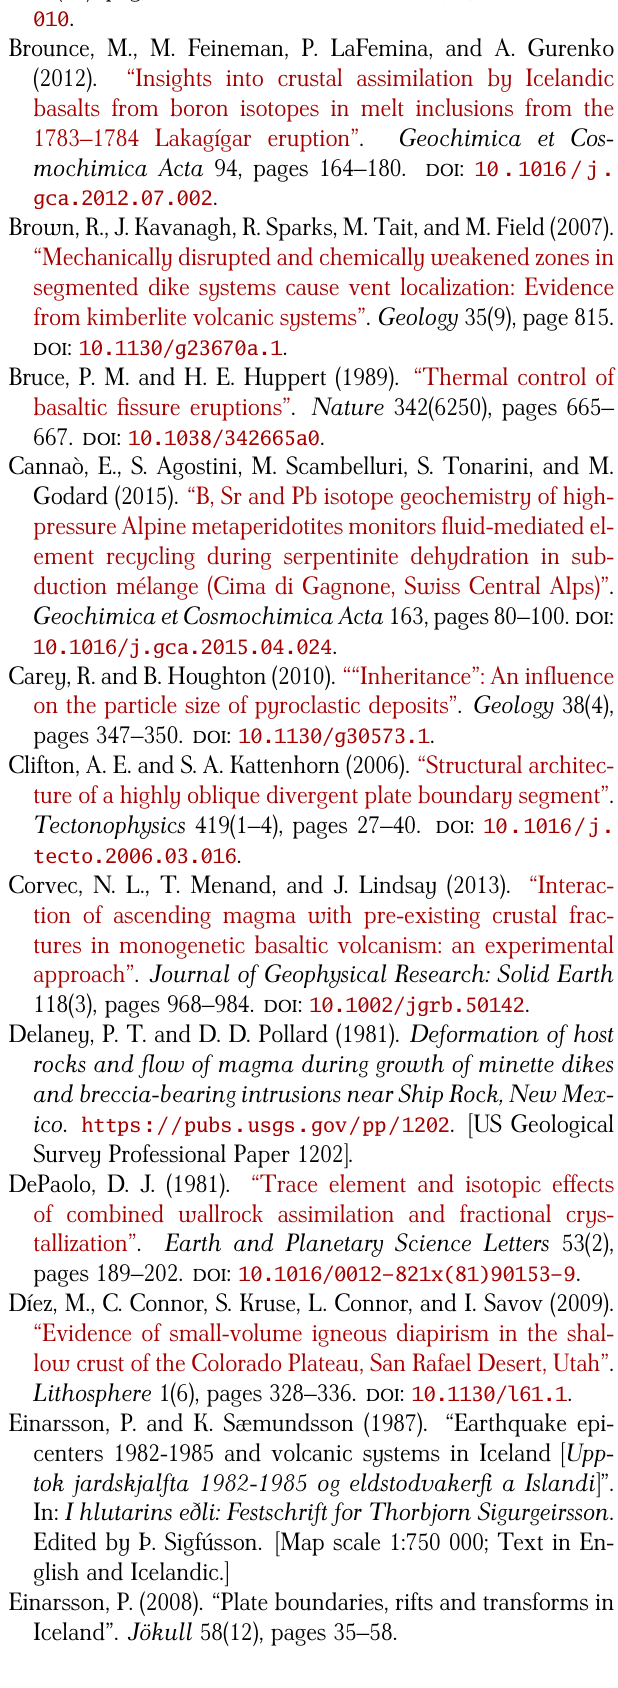
Petrographic data (Table S1) and geochemical data (Table